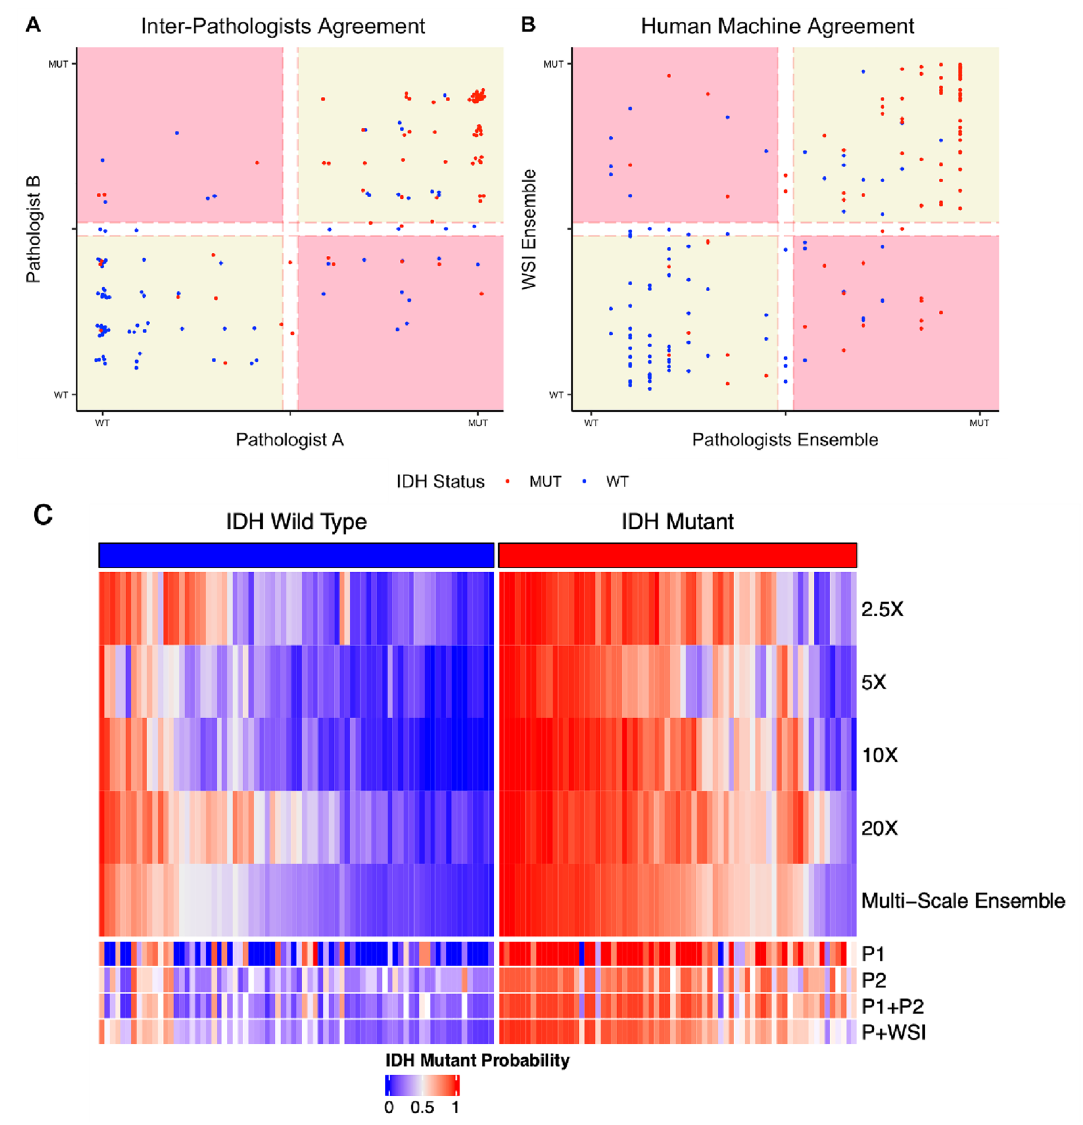
Figure 3. Patient-level predictions in the WCM test data, for the pathologists and ML models. Panel ( A ) compares the semiquantitative prediction scores of the two neuropathologists (κ = 0.656, R = 0.767). Panel ( B ) compares the two-neuropathologist consensus predictions to the multiscale classifier. (κ = 0.598, R = 0.674). Panel ( C ) shows all patient-level predictions using the single-scale models, multiscale ensemble, individual pathologists (P1, P2), two-pathologist consensus (P1 + P2), and the hybrid classifier (P + WSIP1 + MSE). Software utilized the ComplexHeatmap R package (https:// doi. org/ 10. 1002/ imt2. 43) and R version 4.0.3 (2020-